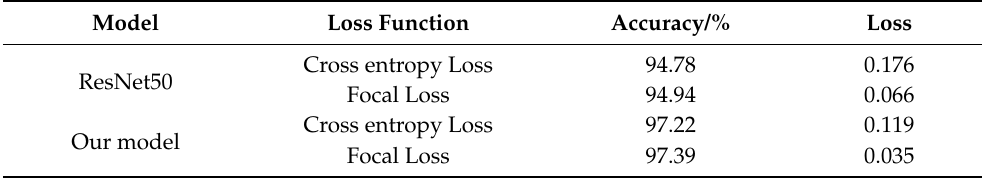
Table 7. Experimental comparison of the results obtained with different loss functions.